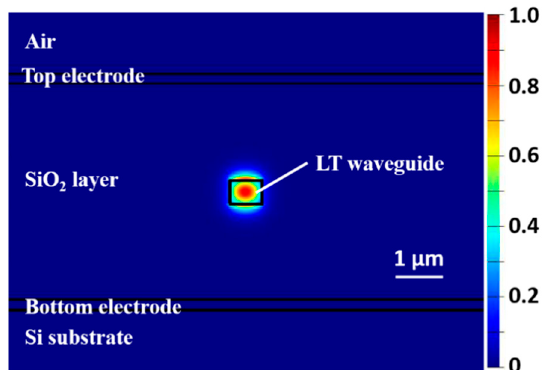
Figure 6. Diagram showing the optical field inside the waveguide.